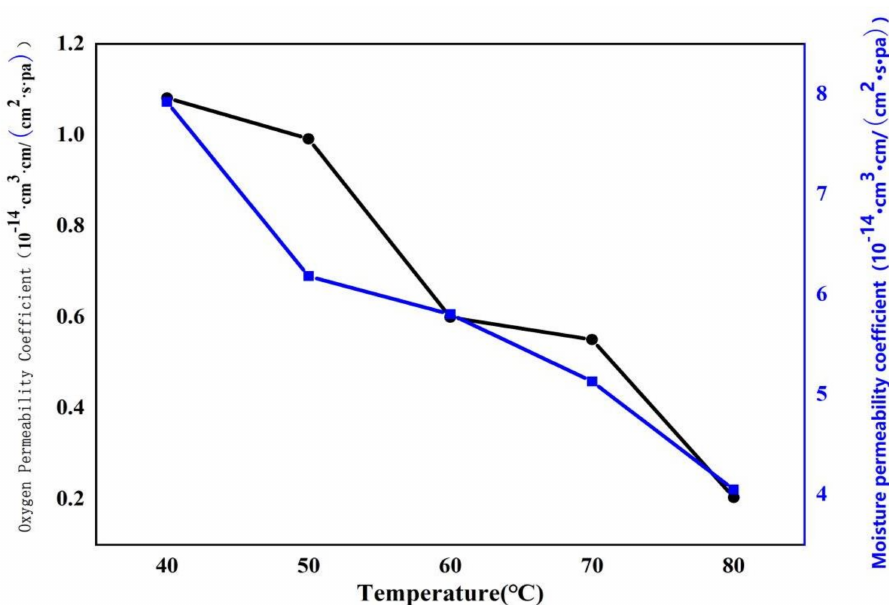
Figure 19. Oxygen permeability of SPU films with different film forming temperatures.